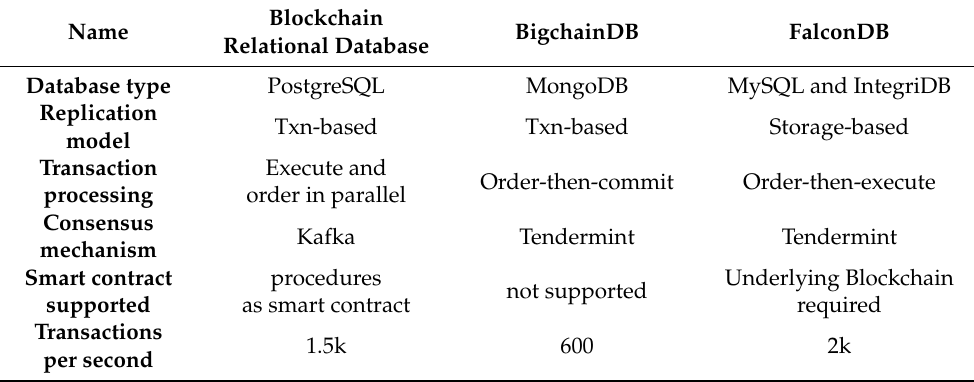
Table 2. Overview of discussed permissioned blockchain technologies.